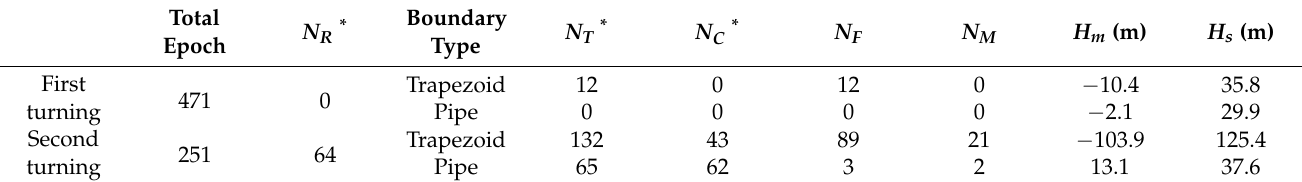
Figure 11. Terrain curve comparison. Table 2. The alert results under two methods in turning flight.